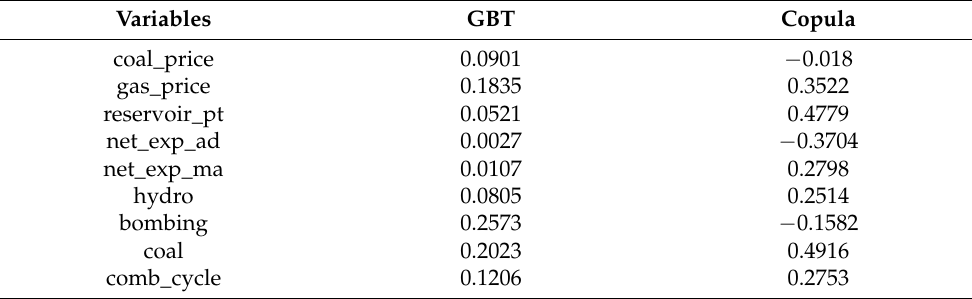
Table 2. Impact score of each variable under the copula and GBT